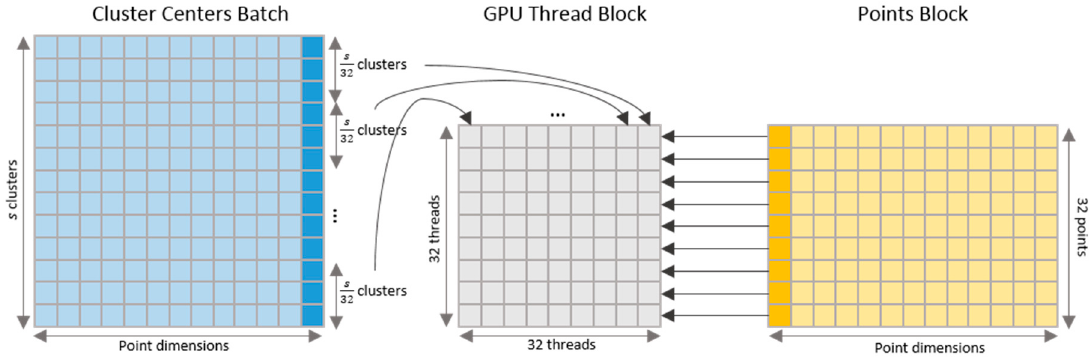
Figure 1. GPU access pattern for the parallel clustering algorithm.